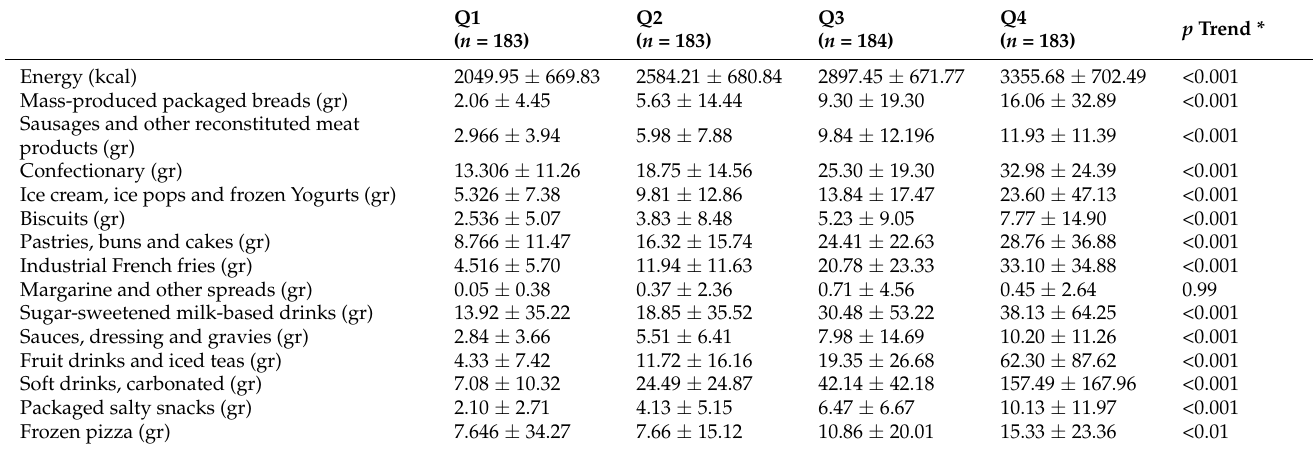
Values are means ± SDs. * Obtained from linear